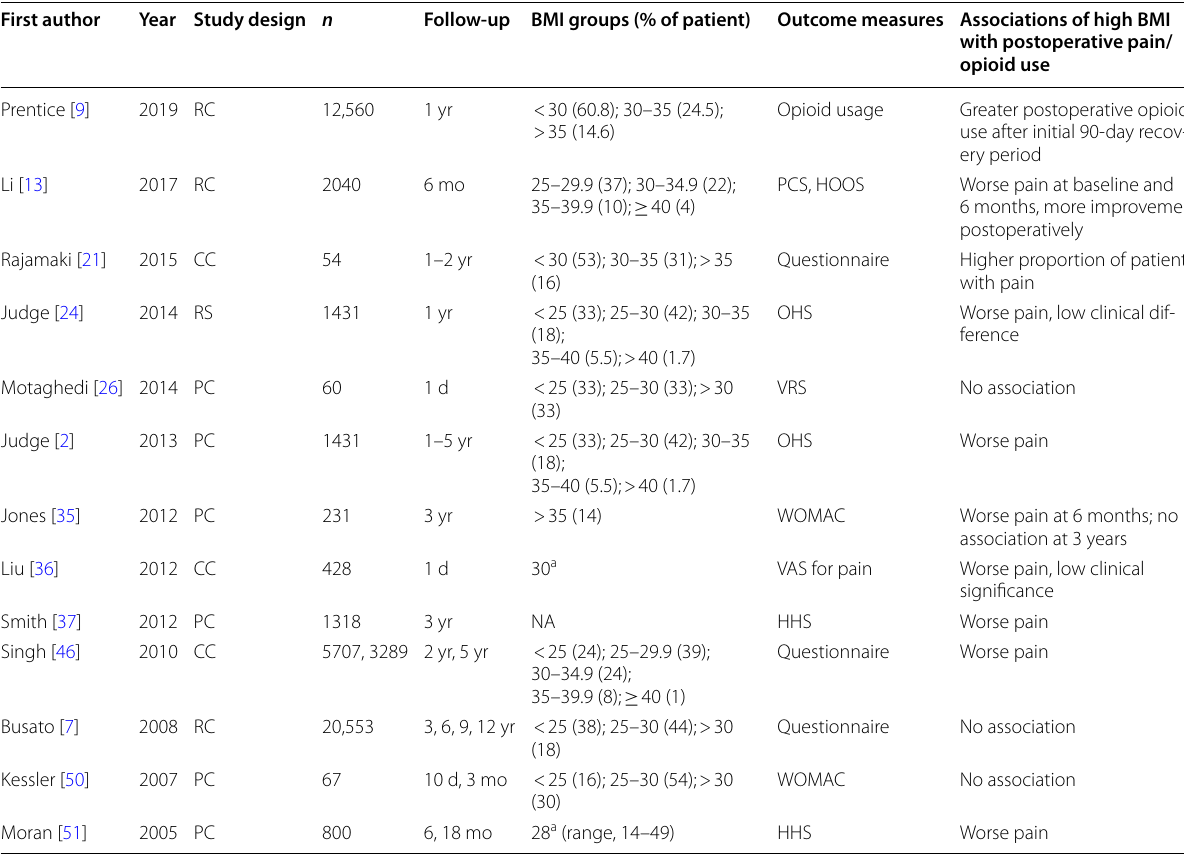
Verbal rating scale a Expressed as mean